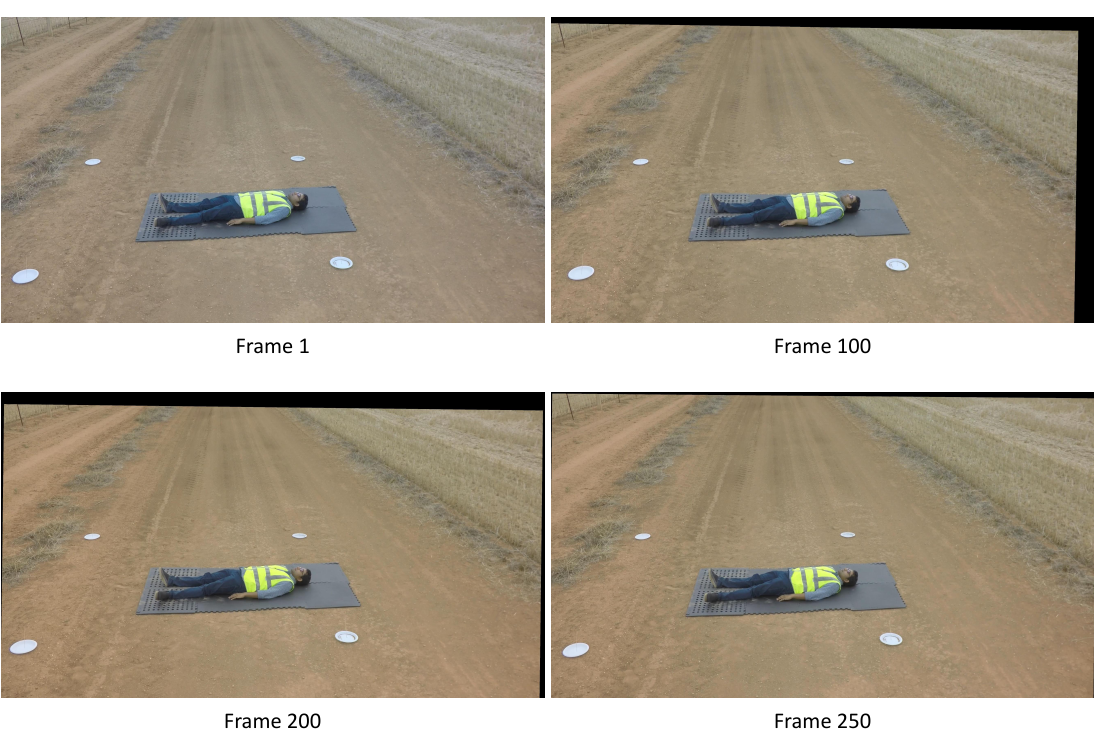
Figure 3. Random frames from the stabilized video A1 (video names are given in Table 1). Black colored areas represent the missing areas after the image transformation.